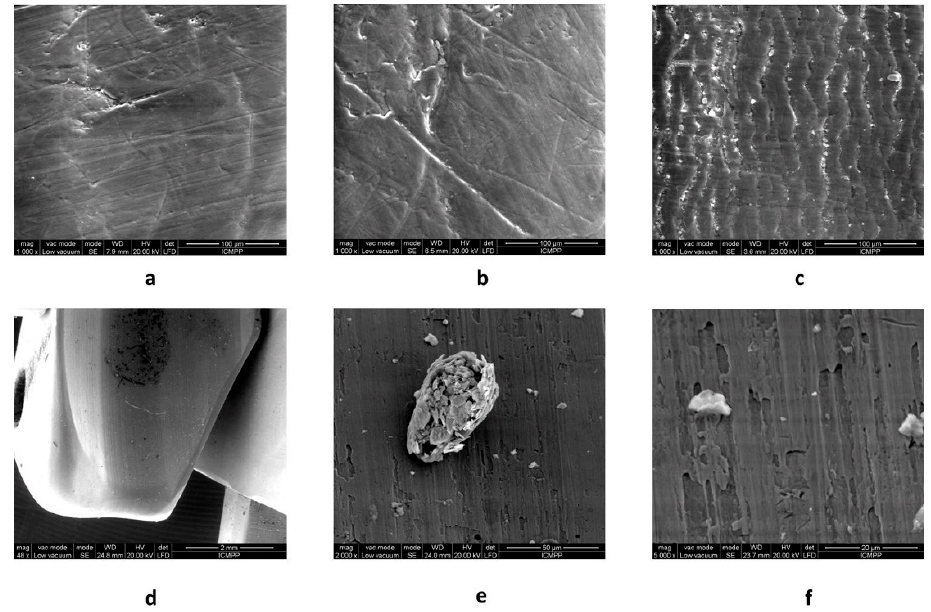
Figure 7. SEM micrographs of elevator and channel samples: a —air/water channel; b —elevator channel; c —working channel; d , e , f —elevator recess side.